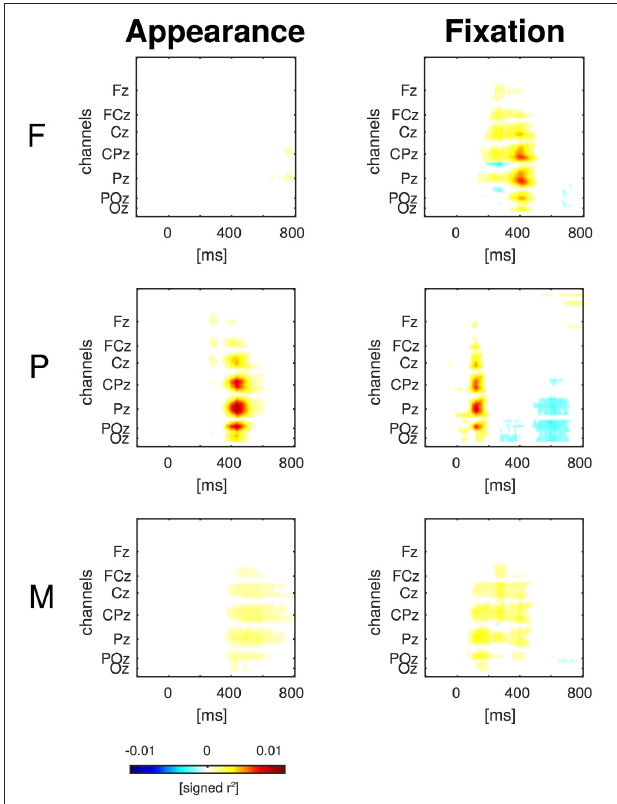
FIGURE 5 | Statistical differences between target and distractor EEG epochs aligned to item appearance and fixation in the conditions F, P, and M (across-subject signed r 2 -values). The channels are ordered from the front to the back of the head (top to bottom in the figure).